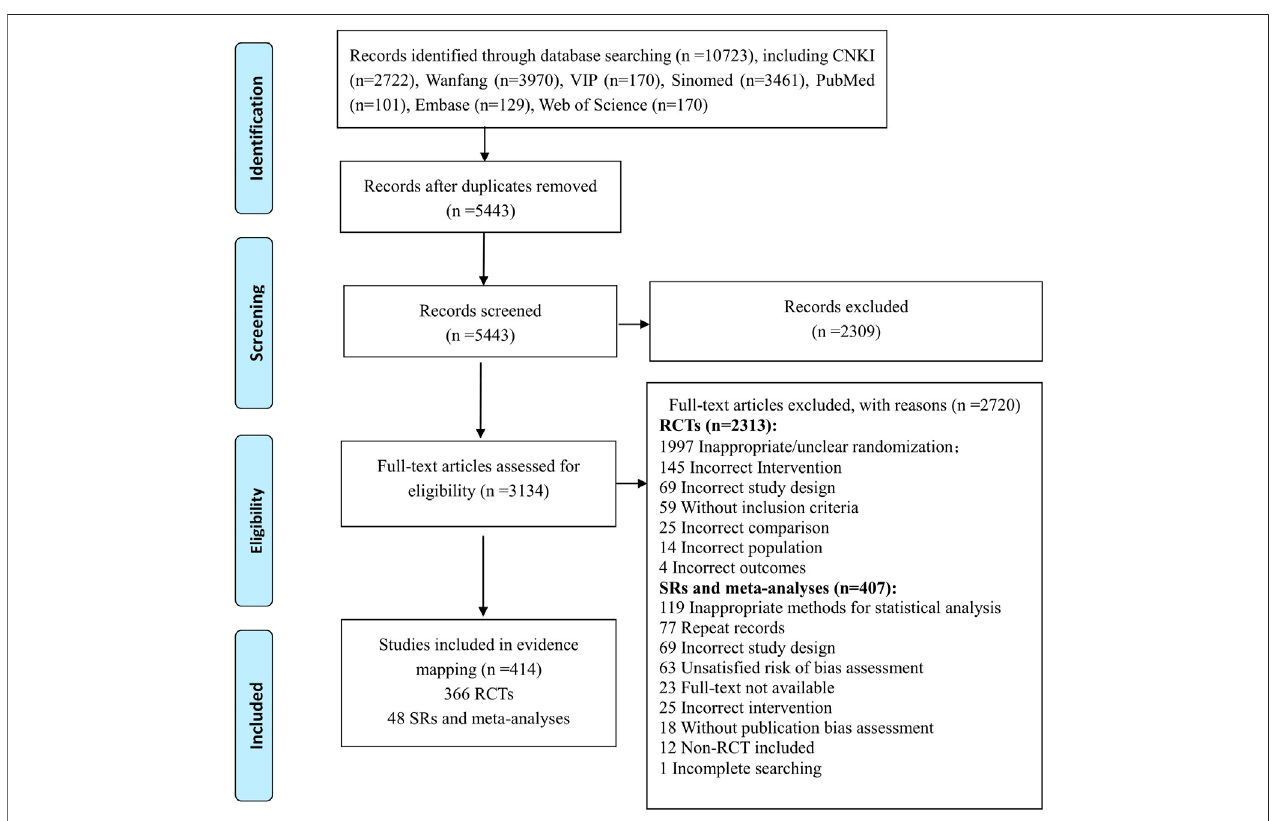
FIGURE 1 | Flow Diagram of the selection of RCTs, systematic reviews, and meta-analyses.